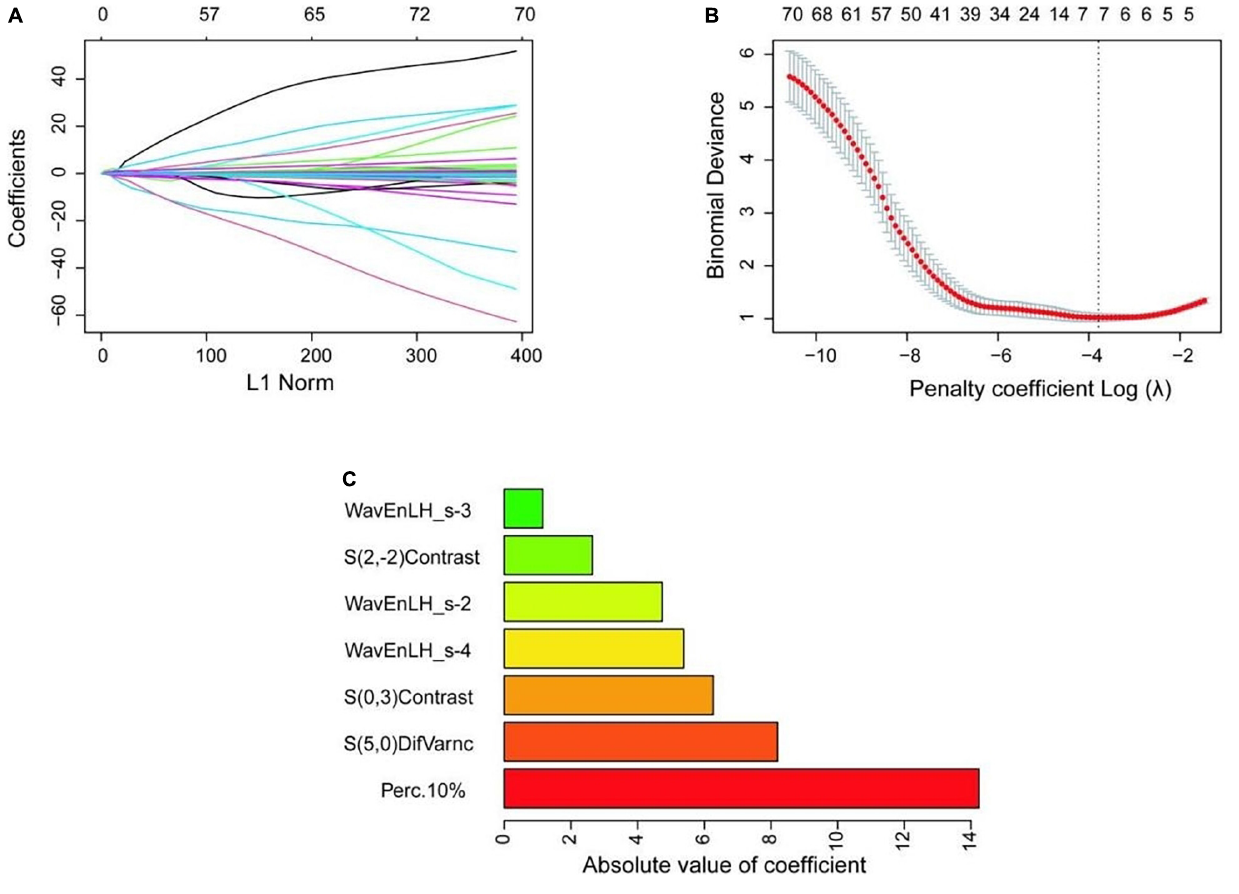
FIGURE 3 | Selection process of texture features. (A) The variation of coefficient of the variable with penalty coefficient. (B) The optimal penalty coefficient is selected by 10-fold cross-validation, and seven optimal texture features are selected when the binomial deviation is the smallest (minimum standard). (C) The absolute value of the coefficient of variables is finally